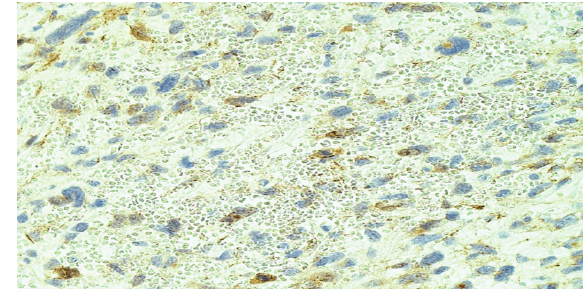
Figure 8: Beta-catenin showing predominantly a cytoplasmic pat- tern of staining in the tumor cells, with scattered nuclei showing mild to moderate immunoreactivity (high power,